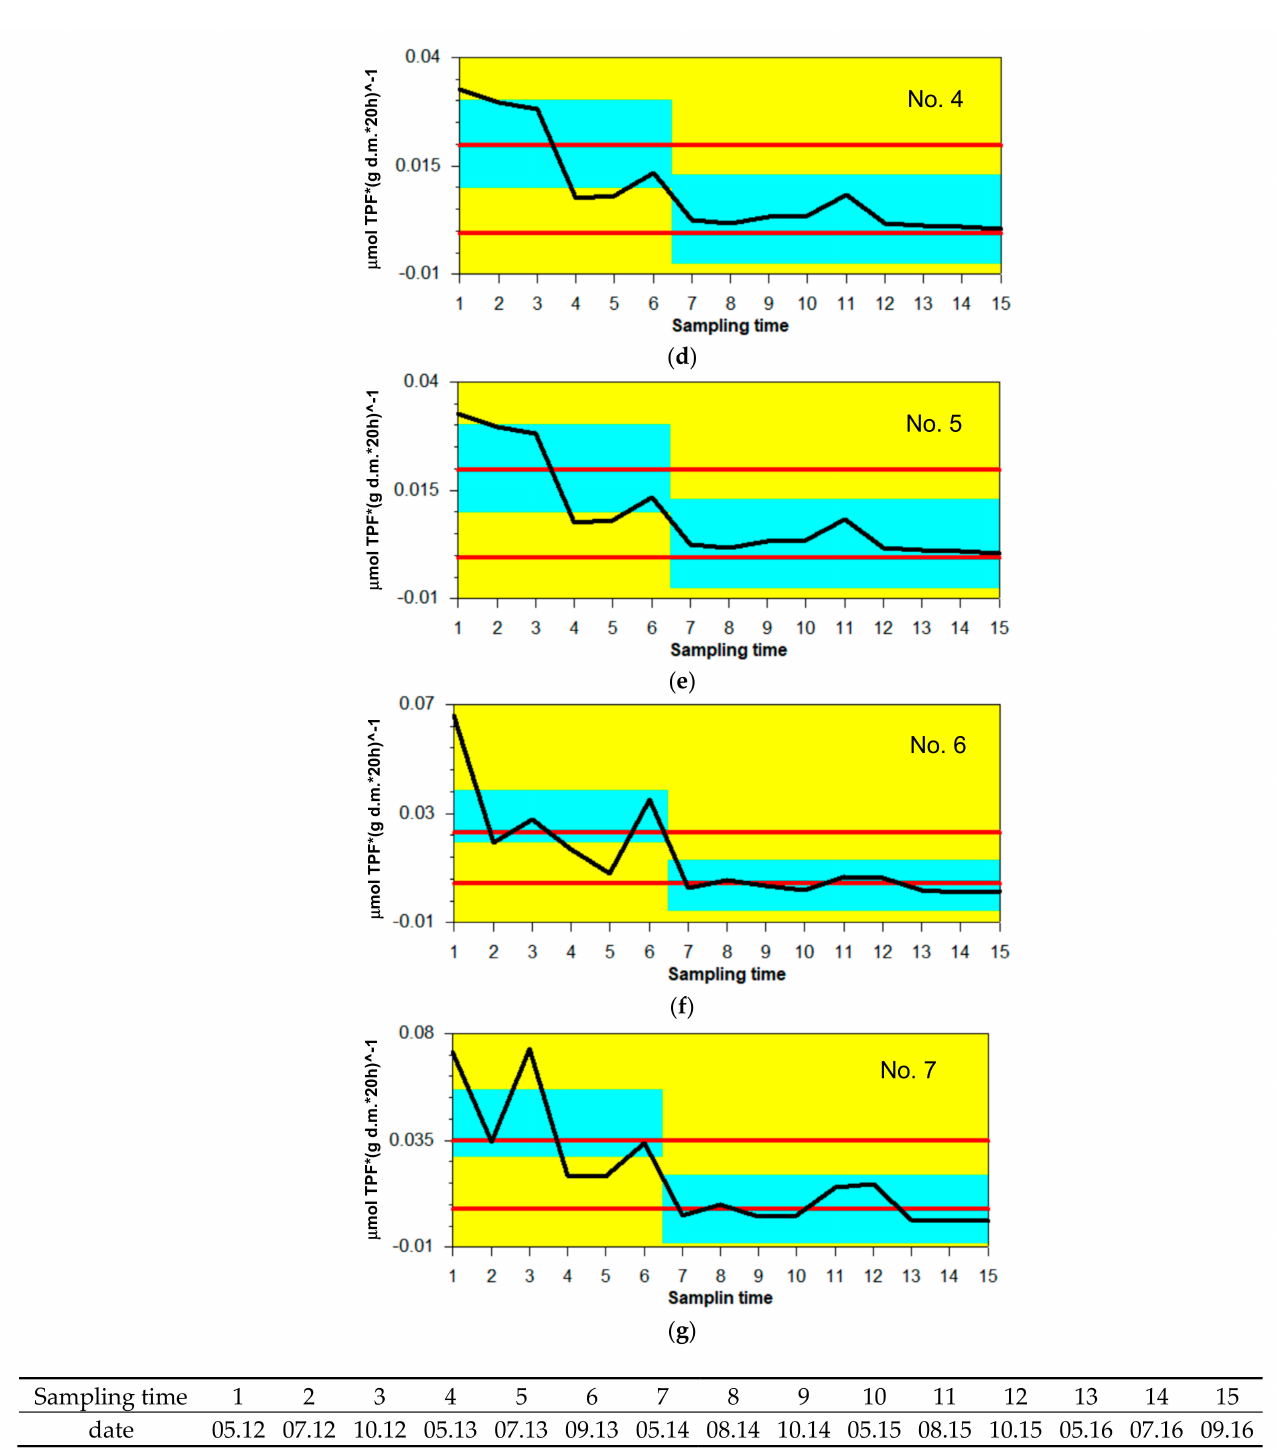
Figure 10. Change—point analysis for dehydrogenases activity on research plots: ( a ) No. 1, ( b ) No. 2, ( c ) No. 3, ( d ) No. 4, ( e ) No. 5, ( f ) No. 6, ( g ) No.